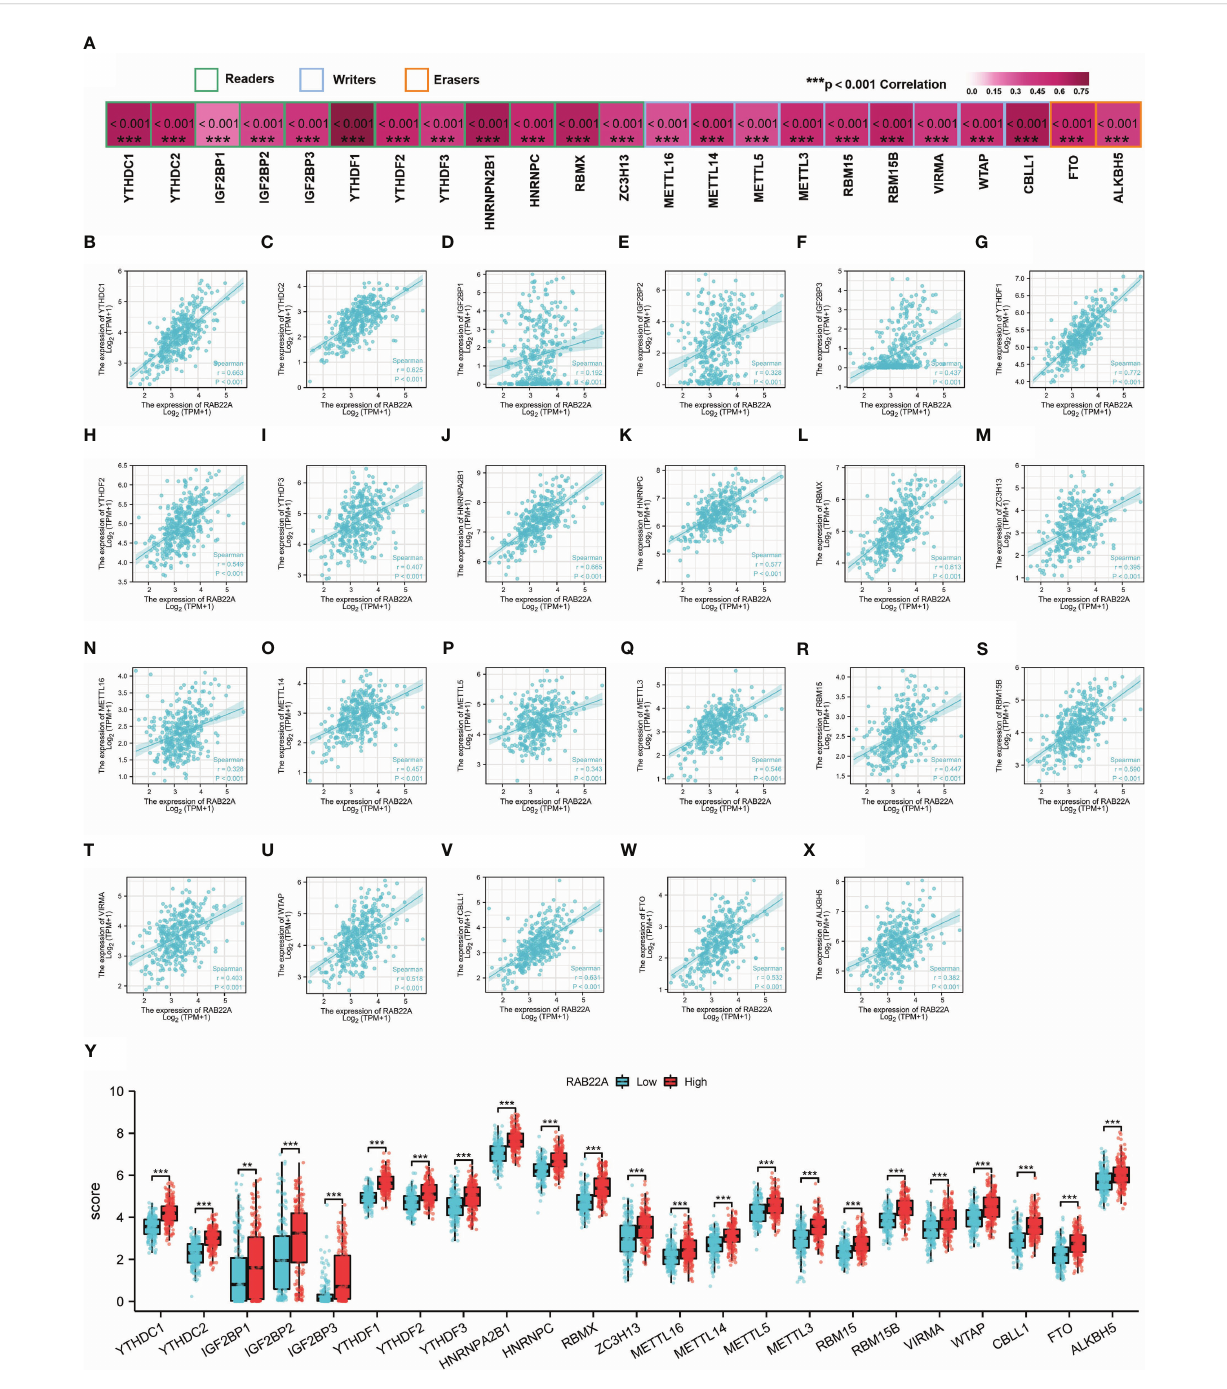
FIGURE 6 Correlation analysis of RAB22A expression levels with m6A-related gene expression in HCC tissues. (A) Correlation of RAB22A expression levels with m6A gene expression in HCC. (B – X) Scatter plot showing the relationship between RAB22A and the m6A gene. Differences in 23 M6A-related genes between the RAB22A high-expression group and RAB22A low-expression group in liver cancer patients (Y) .** p < 0.01, *** p < 0.001, NS, no signi fi